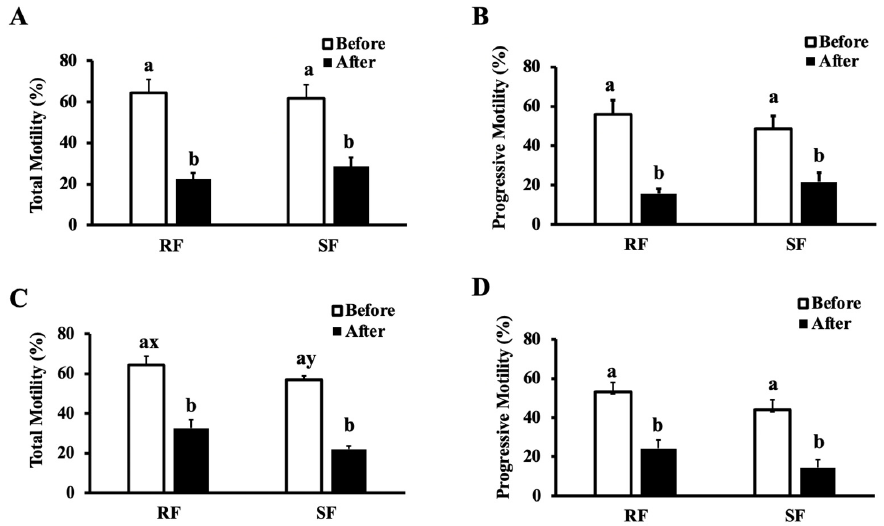
Figure 2. Total and progressive motility of epididymal sperm harvested by retrograde flushing of the tail followed by slicing float-up in donkeys ( A , B ) and horses ( C , D ). Motility parameters were assessed before and after freezing. Different superscript denote differences ( p < 0.05).